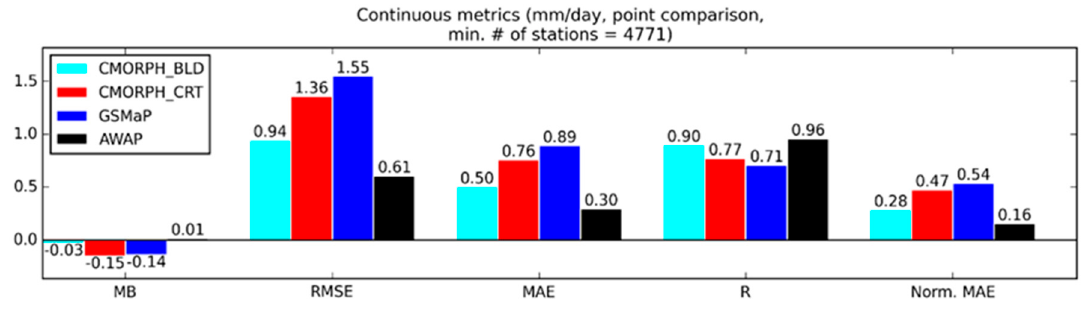
Figure 4. Comparison of satellite datasets against point gauge data from January 2001 to December 2018.